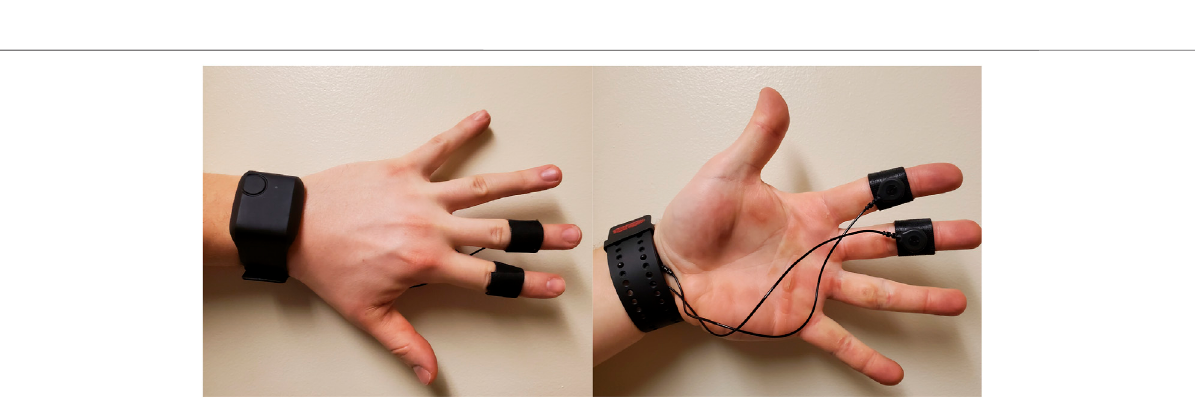
FIGURE 2 | Placement of the Empatica E4 wristband and the EDA